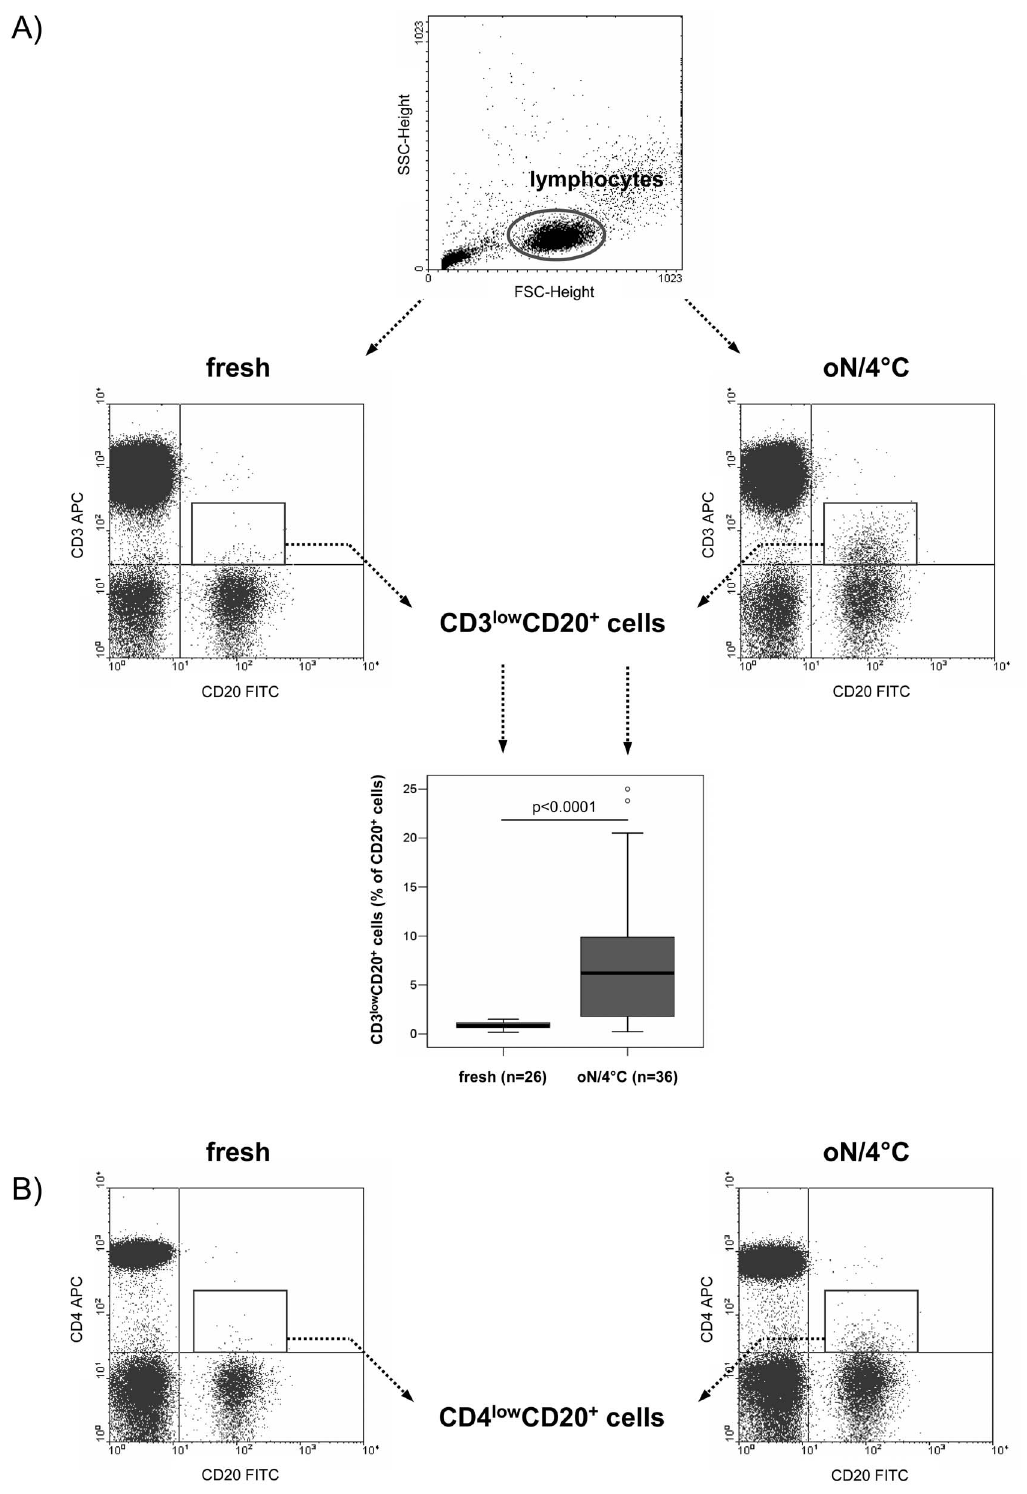
Figure 1. Detection of the T cell antigens CD3 and CD4 on CD20 + lymphocytes by flow cytometry. The appearance of both CD3 (A) and CD4 antigens (B) on the surface of CD20 + lymphocytes is shown for one representative patient. Freshly isolated lymphocytes (left) were compared to lymphocytes analyzed after overnight (oN) storage of whole blood samples at 4 u C (right). The statistically significant difference in the number of CD3- expressing CD20 + (CD3 low CD20 + ) lymphocytes between two independent groups of donors (fresh versus oN/4 u C) was determined by the two-sided Mann-Whitney-U-Test. Outliers are depicted as circles.